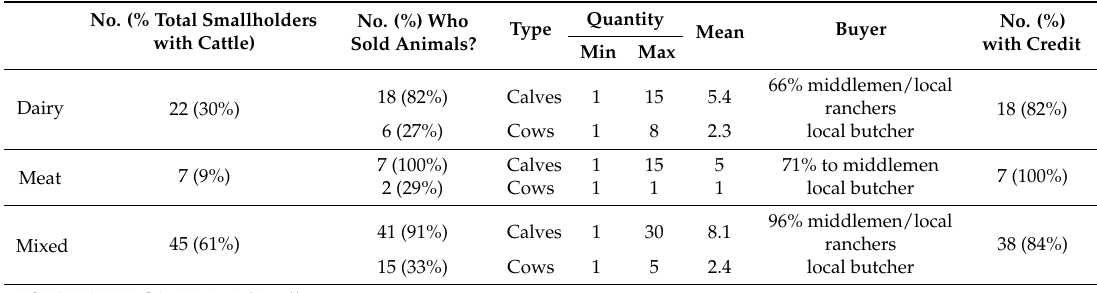
Table 4. Cattle production system characteristics in 2010 ( N =